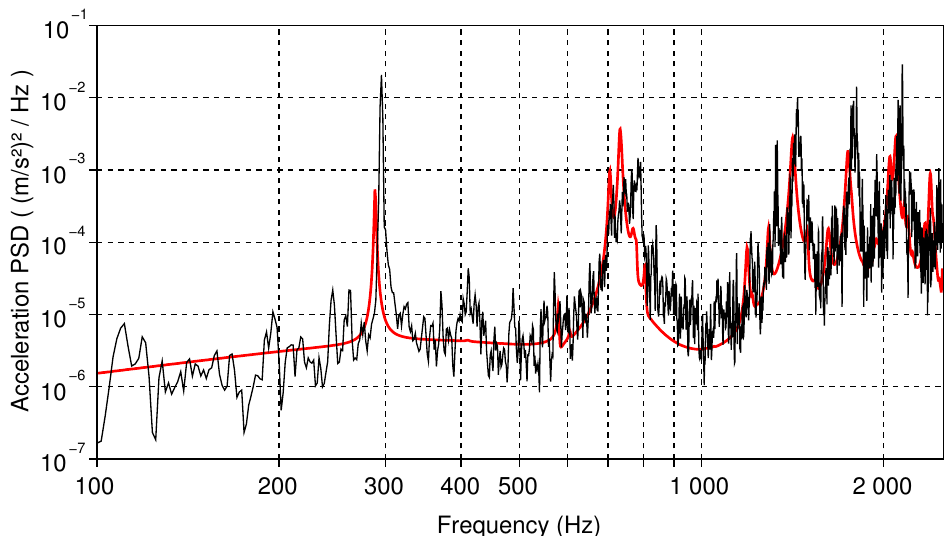
Figure 11. Acceleration PSD at point (b) on the envelope (see Figure 6) with comparison between the experimental data (black) and simulation results (red).